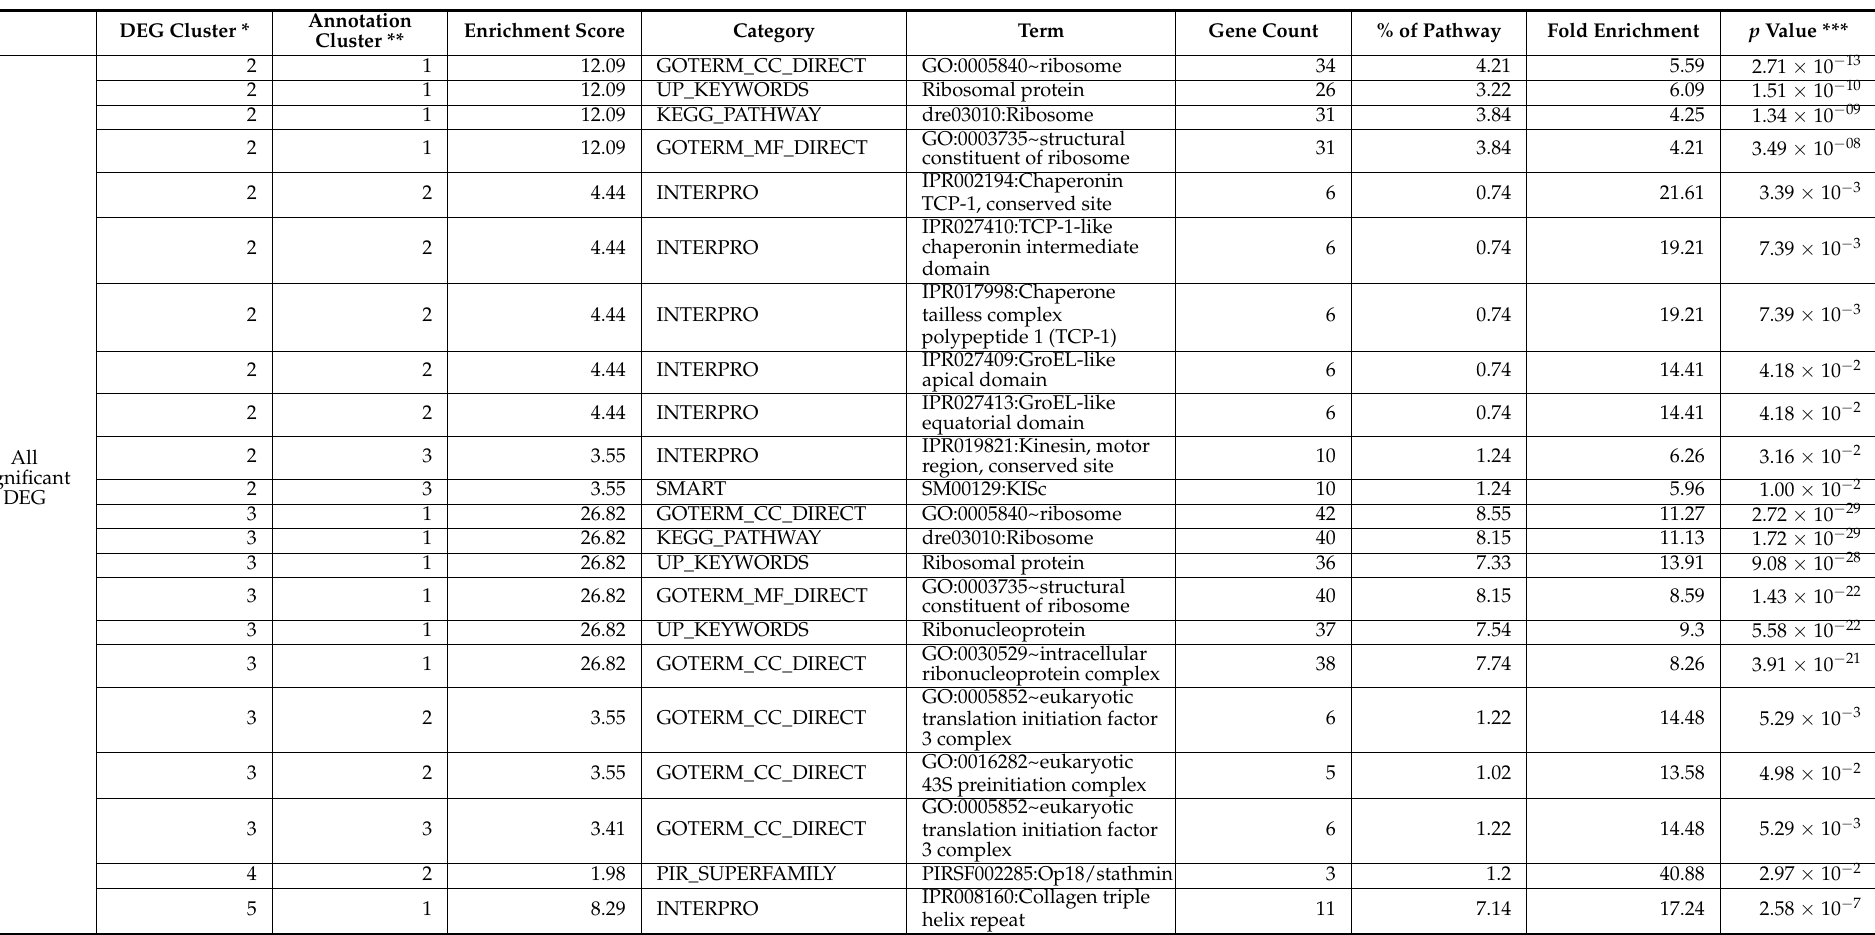
Table 2. Functional pathway annotation of DEG. Differentially expressing genes were clustered into distinct expression profile groups (Figure 7, and extended Table S4). Gene lists from each group were used to query DAVID v6.8 as candidates of shared protein pathways. Significantly enriched pathways were identified using string selection criteria and Bonferroni correction for multiple testing. A full list of gene names is shown in Table S4. * DEG cluster number based on expression profile (as shown in Figure 7). ** DAVID functional annotation pathway cluster. *** Bonferroni corrected p